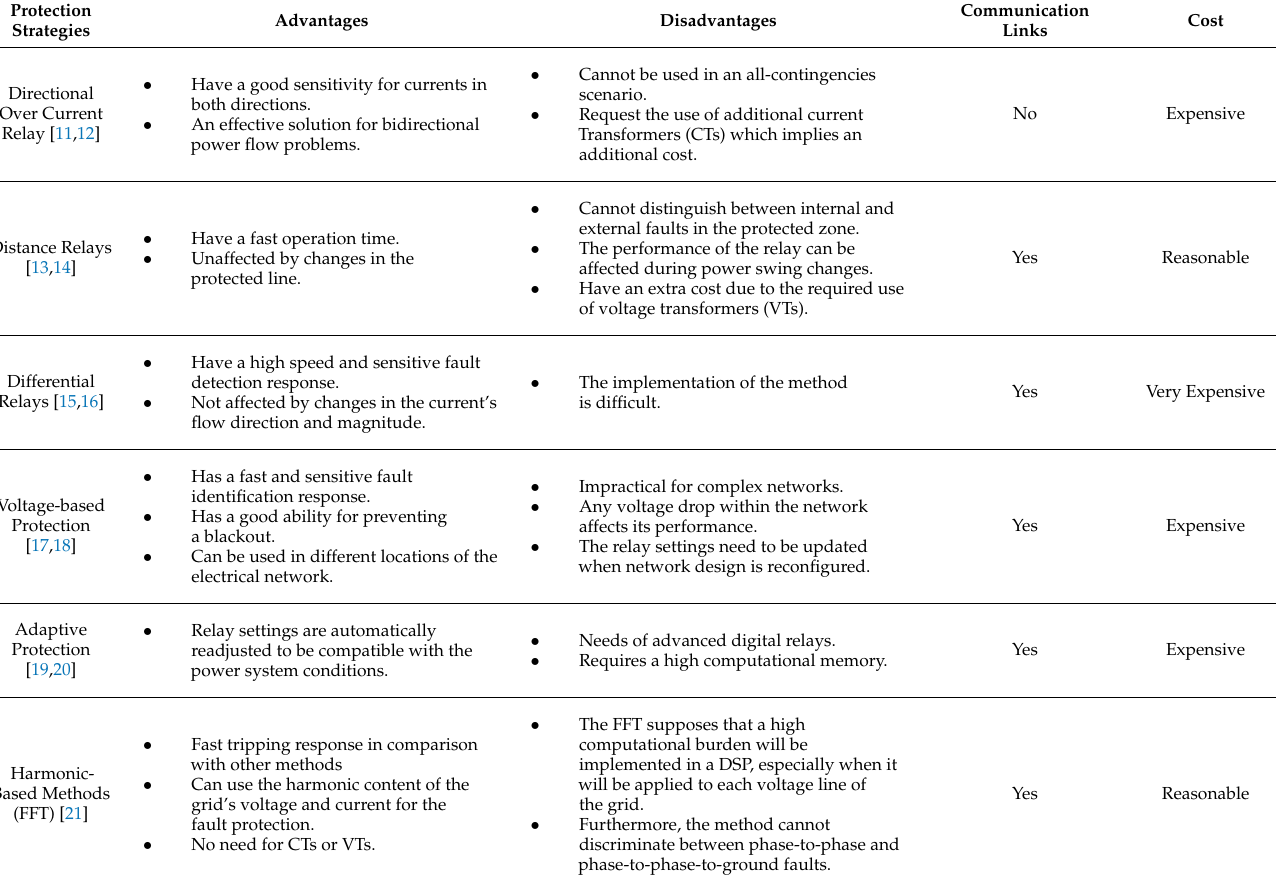
Table 1. Comparison of common fault protection techniques for